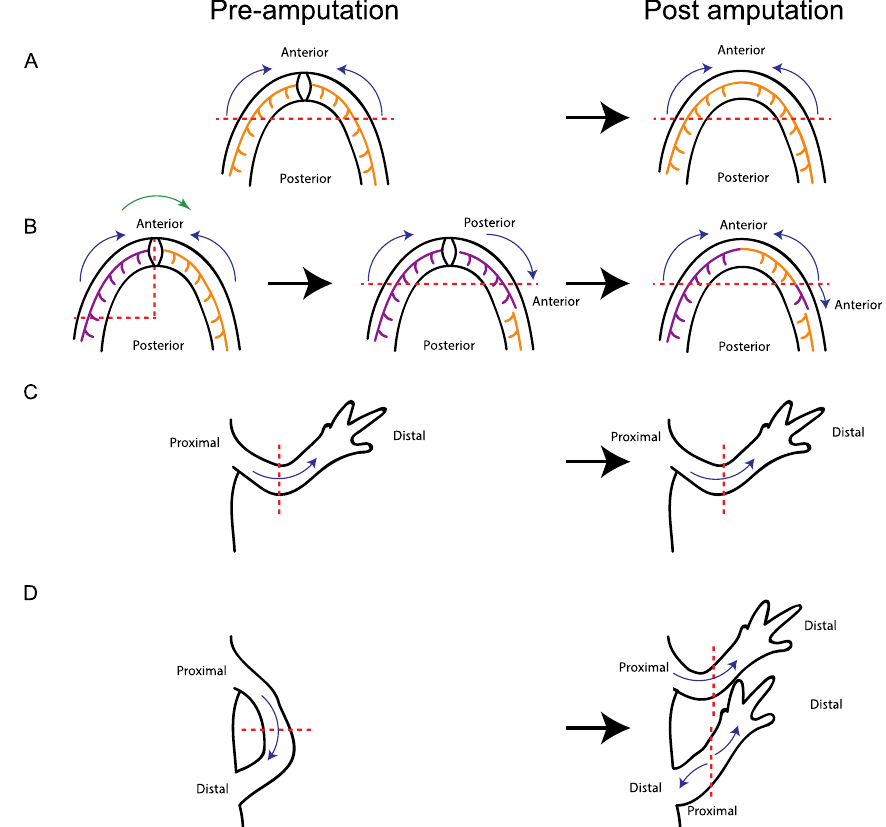
Figure 3. Plasticity of tissue polarity during jaw and limb regeneration is conserved. ( A ) Jaw regeneration normally occurs with a posterior to anterior polarity; ( B ) When a portion of the jaw is reversed along its anterior-posterior axis and amputated, rather than generating structures that are posterior to the amputation plane, the blastema cells reverse their polarity so that they only regenerate structures anterior to the amputation plane. Dental lamina migrates into the adult jaw regenerate in a unidirectional manner, from posterior to anterior; however, the dental lamina migrates into the regenerate in the appropriate direction, despite the grafted tissue being rotated relative to the host site and regenerate; ( C ) During normal limb regeneration, the regenerate retains the proximal/distal polarity of the original limb; ( D ) Limbs with reversed proximal/distal axes can be generated by attaching the autopod to the flank. When the limb is amputated, the part of the limb that remains attached to the flank has the reverse proximal/distal orientation. However, rather than regenerating limb structures proximal to the wound site, the blastema reverses its polarity such that it regenerates tissue distal to the amputation plane. Therefore, there is a conserved mechanism, which prevents regeneration in a proximal direction. Red dashed lines represent the plane of amputation. Blue arrows indicate the direction of tissue polarity. Purple and orange lines represent dental lamina. Green arrow represents tissue grafting. Black arrows represent amputation and regeneration time.